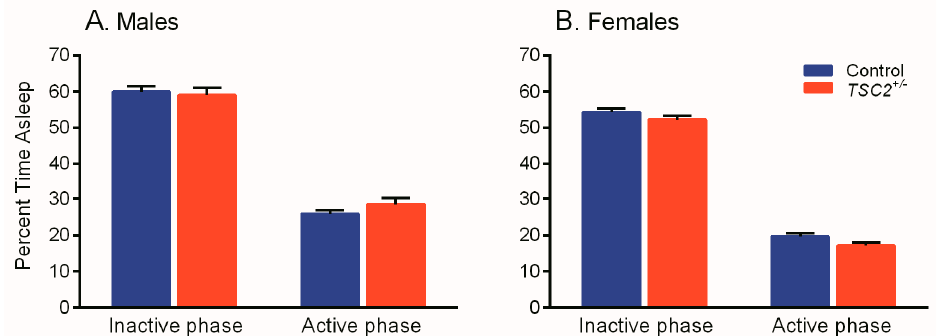
Figure 1. Sleep duration in Tsc2 +/ − and control male ( A ) and female ( B ) mice. We found statistically significant main effects of phase and sex, but no statistically significant interaction or main effects of genotype (Table 1). Mice slept less in the active phase than in the inactive phase ( p < 0.001). Females slept less than male mice ( p < 0.001). Bars represent means ± SEM for 22 control male, 22 Tsc2 +/ − male, 23 control female, and 21 Tsc2 +/ − female mice.